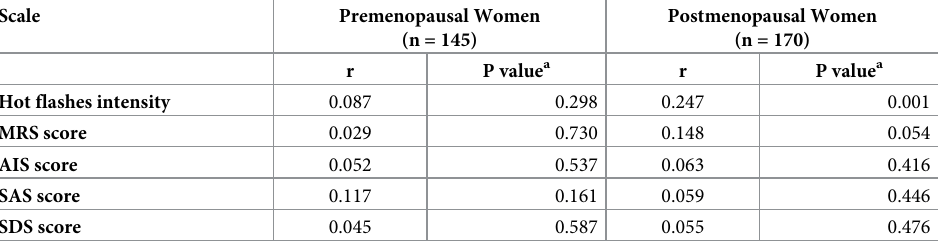
Table 3. Relationship between stress score and menopausal symptoms scores in study